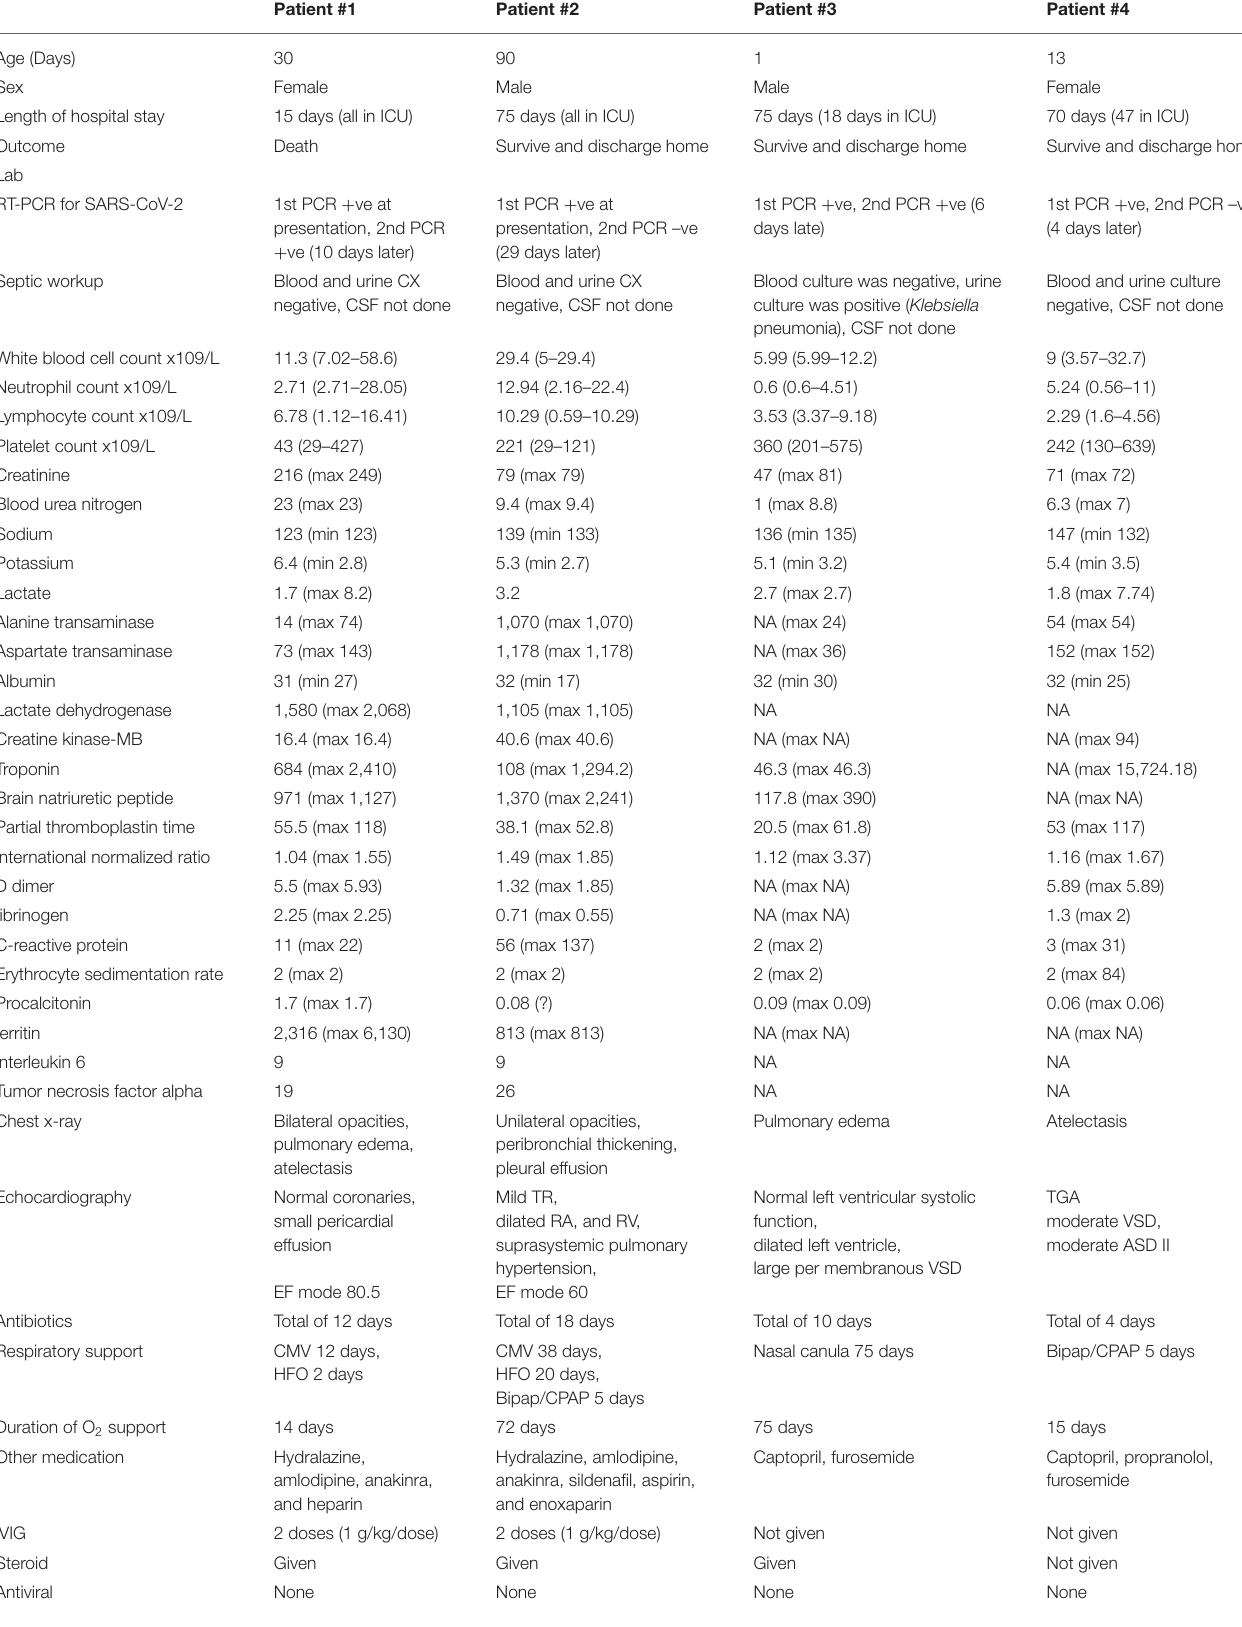
TABLE 2 | Characteristics and outcomes of severe/critical